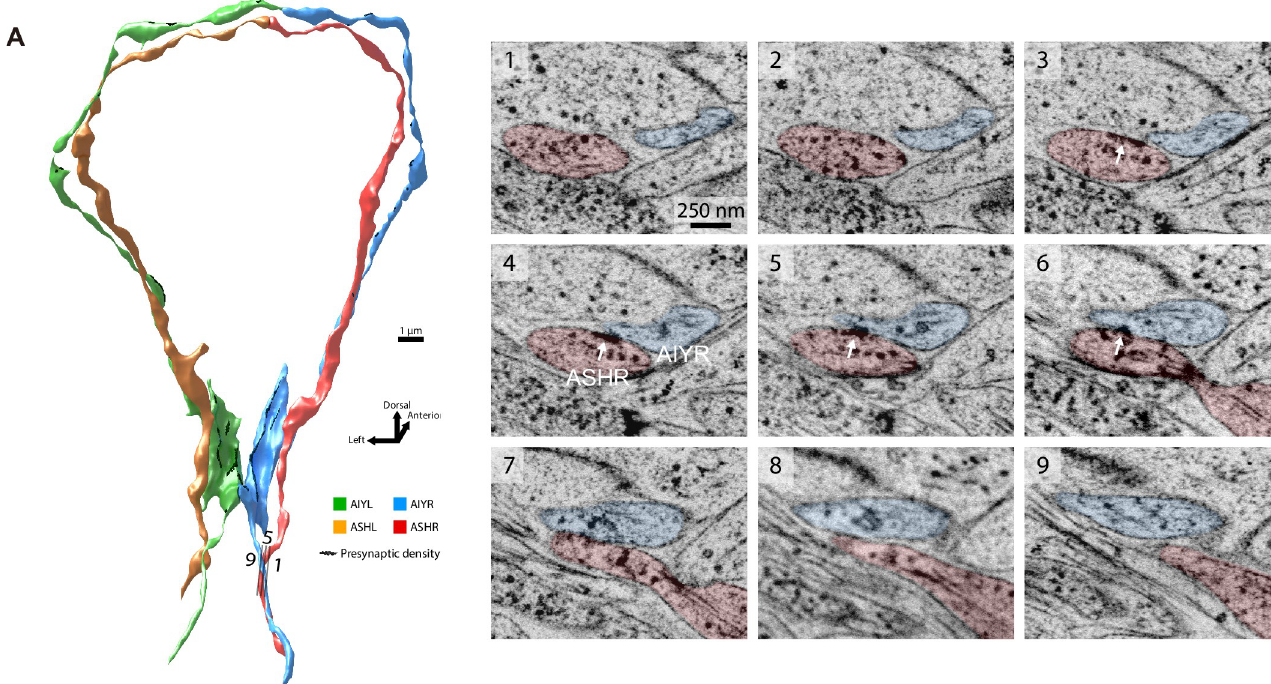
Fig 6. ASH neurons are AIY presynaptic partners. (A) Left: the 3D model shows the anatomic relationship between ASH and AIY. Right: nine consecutive high-resolution EM micrographs (slide 1, 5, and 9 are labeled in the 3D model) from an adult hermaphrodite show the synaptic connection between AIY and ASH at the anterior region of zone 1, near zone 2. Identified synapses from ASH to AIY are labeled with an arrowhead (image 3, 4, 5, 6). Scale bars are 1 μ m (left) and 250nm